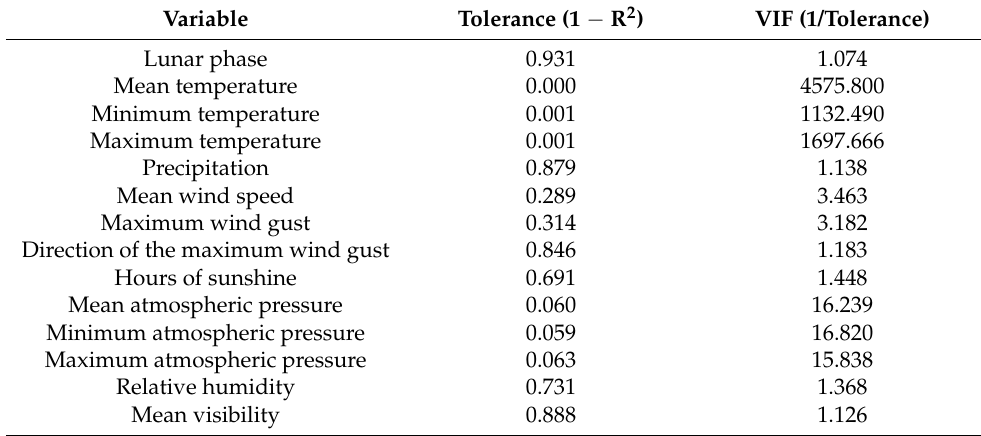
Table 1. Multicollinearity analysis of lunar phase and weather-related variables to discard redun- dant